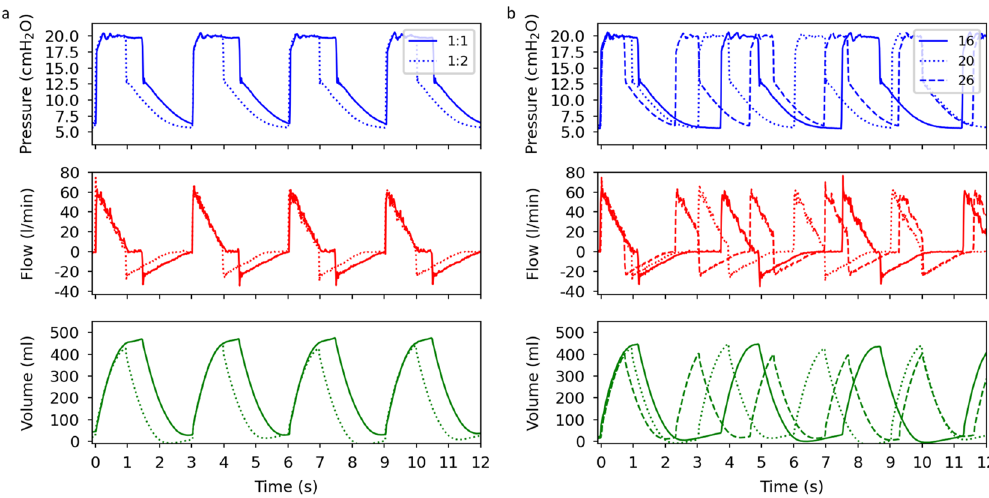
Figure 2. Plots of the airway pressure, flow, ventilation volume as a function of time. ( a ) Ventilation data plots acquired for the I:E ratios 1:1 and 1:2 while the respiratory rate and the P IP value are set to 20 bpm and 20 cmH 2 O, respectively. ( b ) Ventilation data plots acquired for the respiratory rates 16 bpm, 20 bpm and 26 bpm while the I:E ratio is 1:2 and the P IP value is 20 cmH 2 O. All measurements are conducted on an artificial lung and the pressure is generated with the CPAP machine u1 (see Table